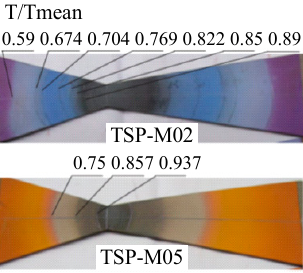
Figure 13. Temperature test of the standard temperature-sensitive paint (TSP) model.